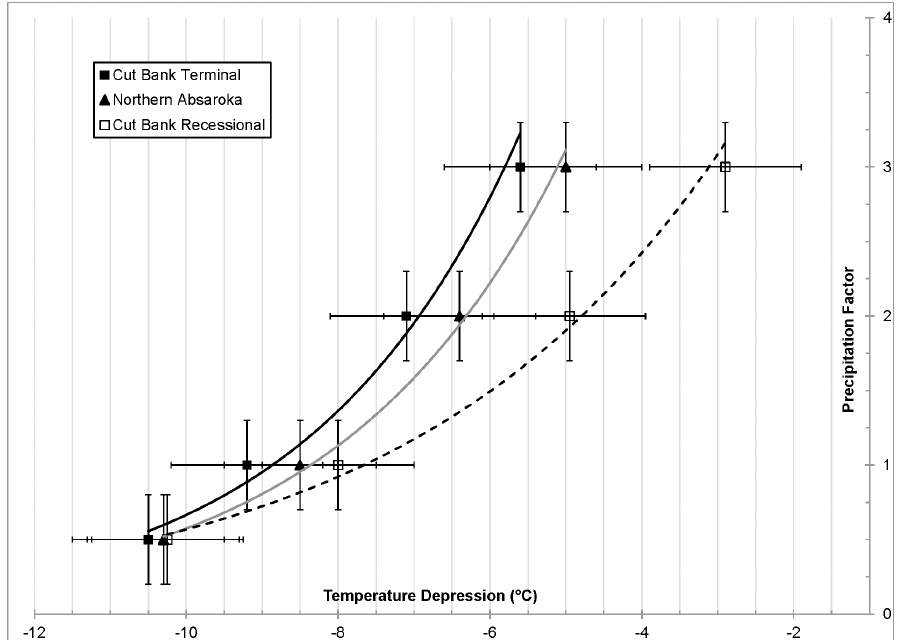
Figure 7. Multiplicative precipitation factors and temperature depressions, both with respect to modern, that produced modeled ice extents matching field mapped extents for (1) Cut Bank terminal moraine, (2) northern Absaroka Range Pinedale maxima at Pine Creek and South Fork Deep Creek, and (3) Cut Bank recessional